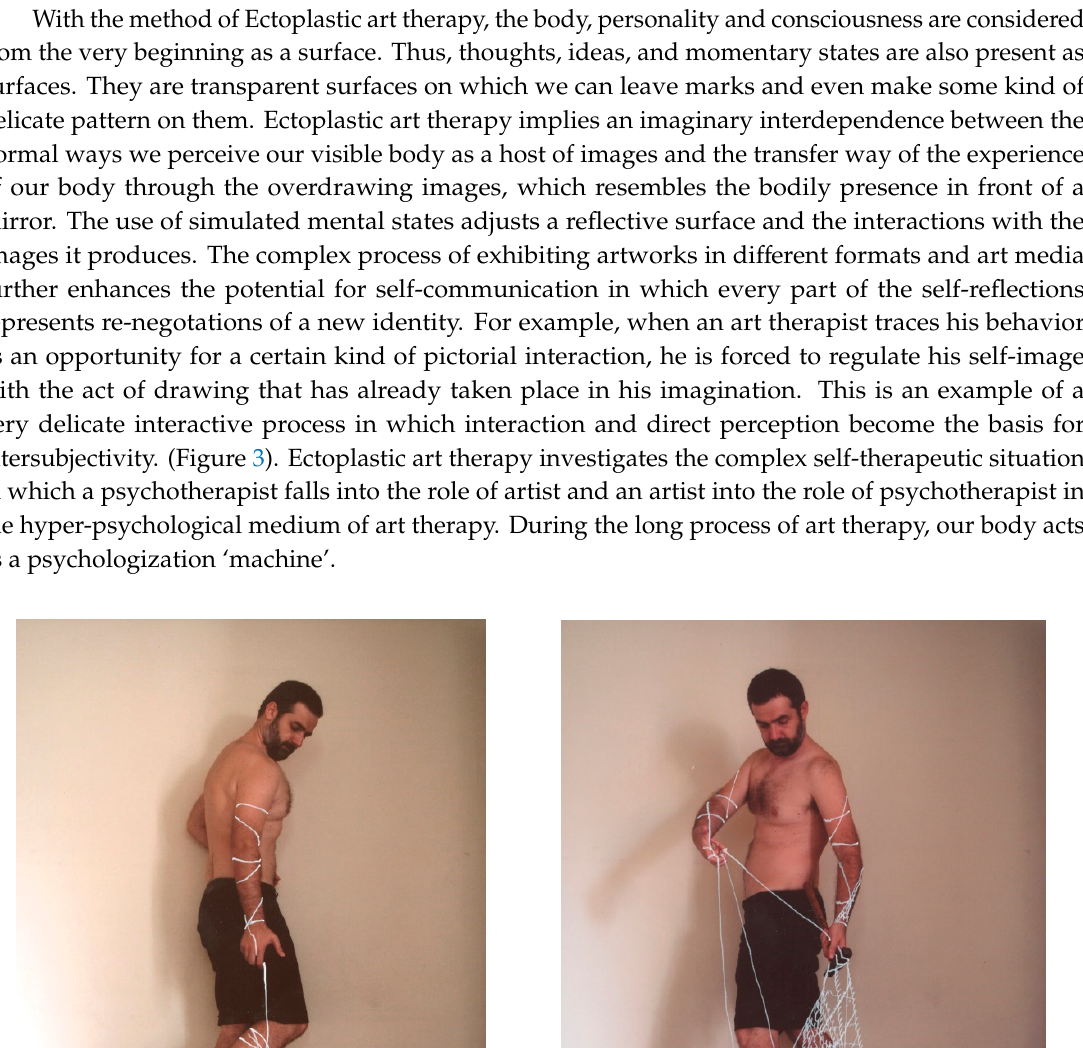
( b ) Figure 4. Peter Tzanev, Ectoplastic exercises: ( a ) Out-of-Body Experience, 2018; ( b ) Out-of-Body Experience, (detail), 2018; photos: P. Tzanev, 2018.